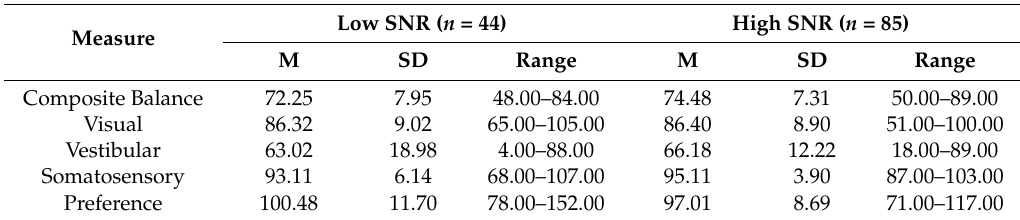
Table 3. Neurocom data descriptives compared with low and high sit and reach